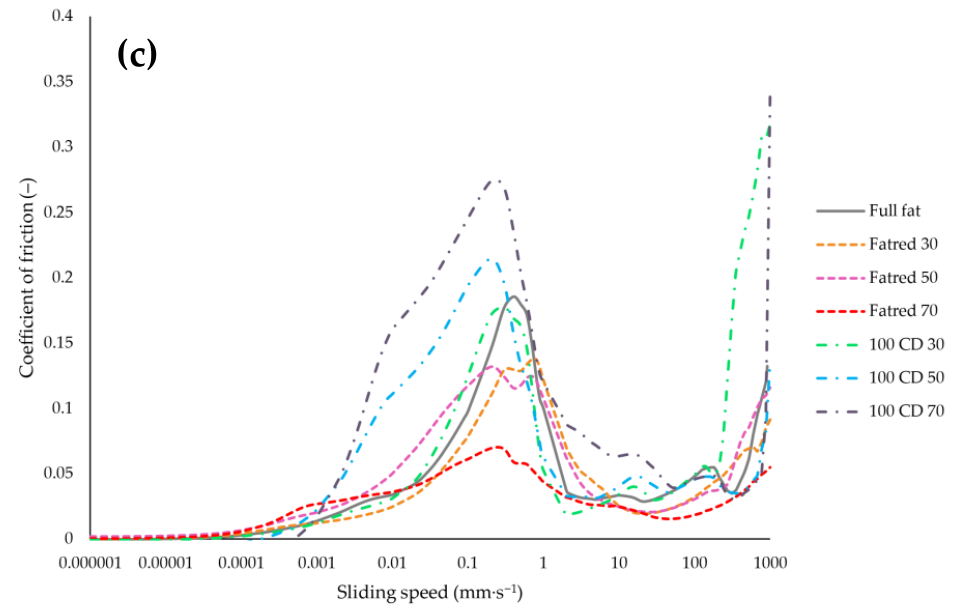
Figure 7. Stribeck curve 1 ( a ), curve 2 ( b ), and curve 3 ( c ): coefficient of friction versus sliding speed of PCS samples with different fat contents. The curves are mean values of all four measurements per each batch.